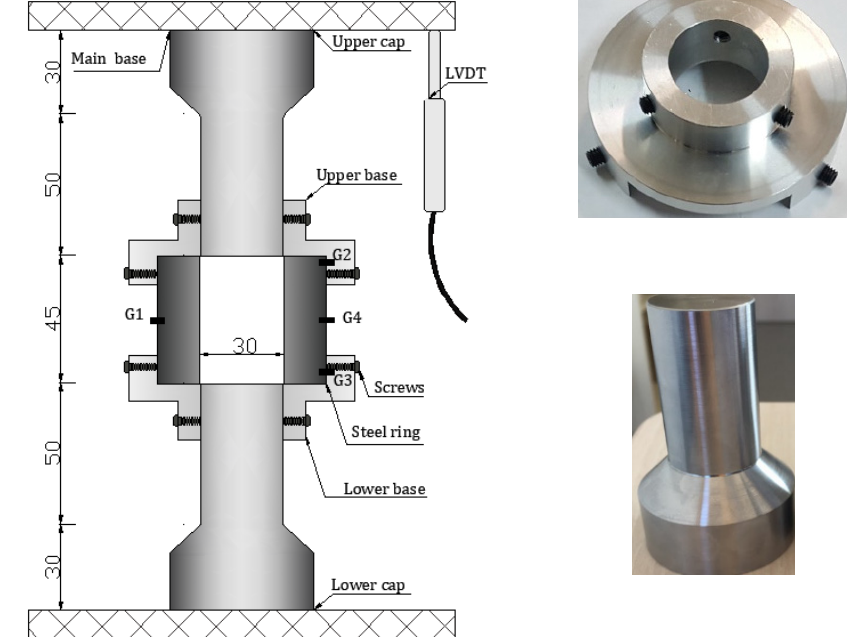
Figure 2. QOC test apparatus, modified set up. Steel confining ring instrumented with four gages, steel plugs and aluminum base being machined. All dimensions are in millimeters.